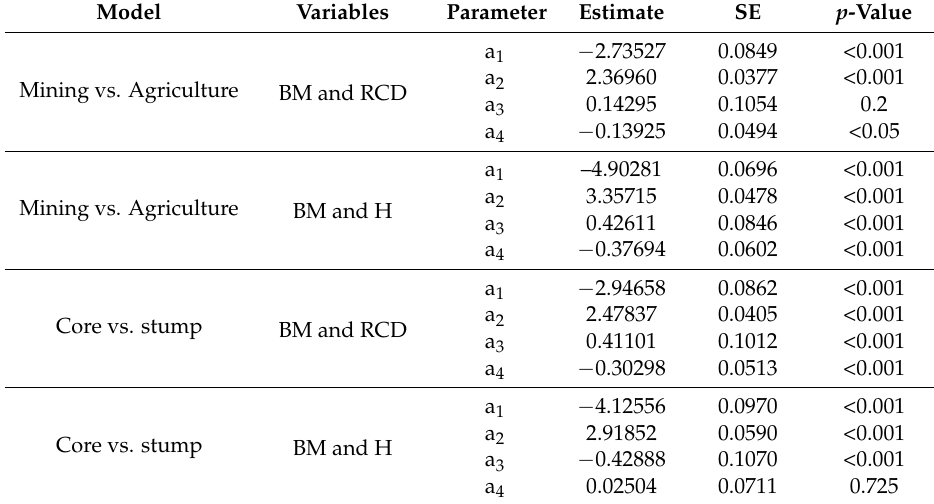
Table 6. Comparing different sites and growth conditions by using dummy variables of power regression in the mixed models, with woody biomass (BM) as the response variable and the tree variables root collar diameter and height as predictor variables, for mining, agriculture, core, and stump (Equation (10)). The table below shows the parameter (a 1 , a 2 , a 3 , a 4 ), estimates, standard error (SE), and p -value ( n =